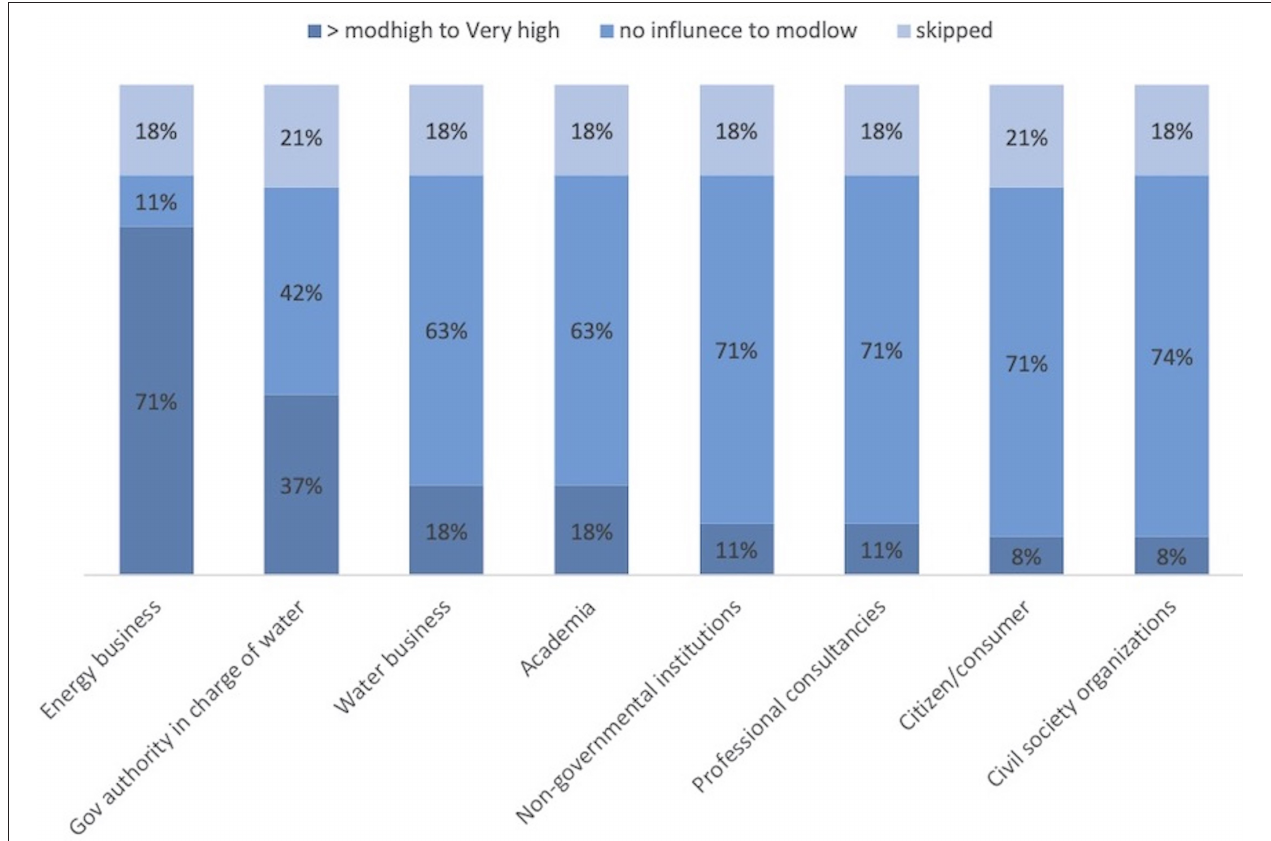
FIGURE 8 | Perceptions of issues involving the non-integrated areas of water and